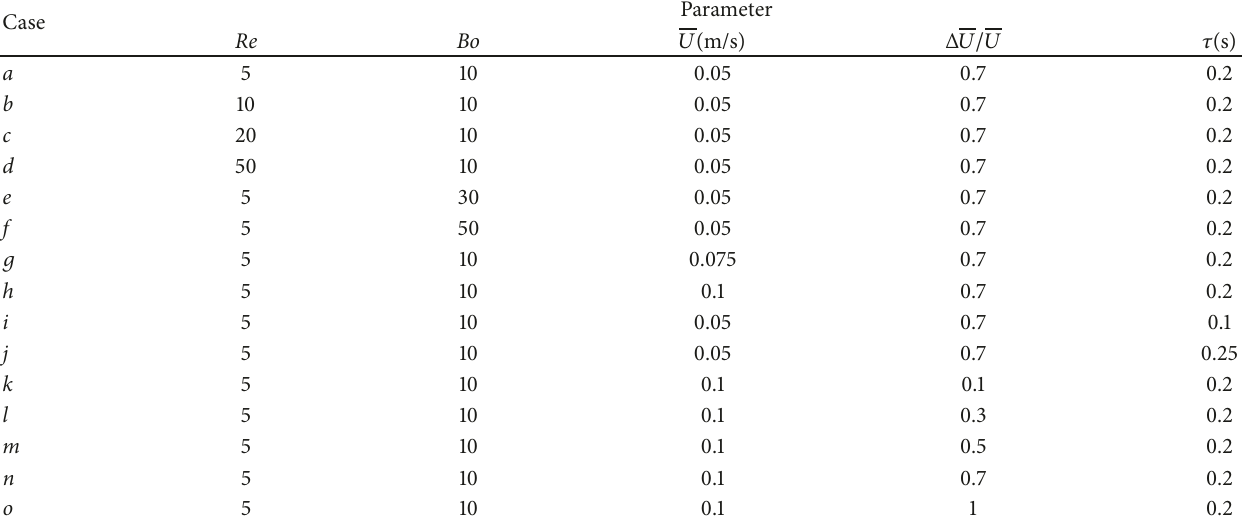
Table 2: Cases simulated in Section